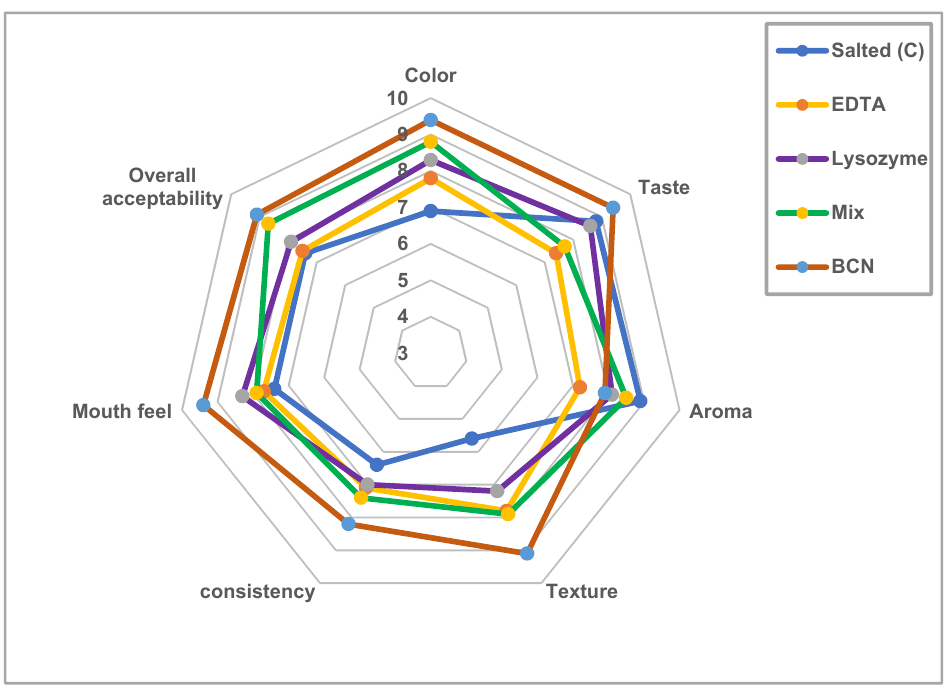
Figure 2. The sensory evaluation results of the salted mullet are enhanced by coating before the salting process. The sensory evaluation data for the salted mullet are represented as means of panelist degrees. Lysozyme was applied at 100 ppm concentration; the EDTA was used at 1 nM concentration. Mix solution was prepared from lysozyme (100 ppm) and EDTA solution (1 nM).